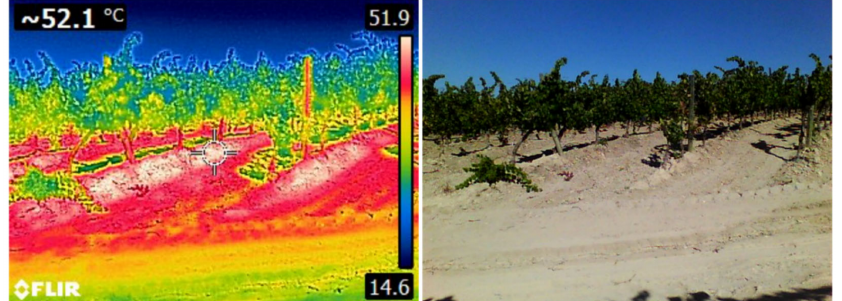
Figure 3. Differences in temperature reached by the soil, the canopy and the shadows cast by the canopy in a vineyard in C á diz, Southwest Spain, at